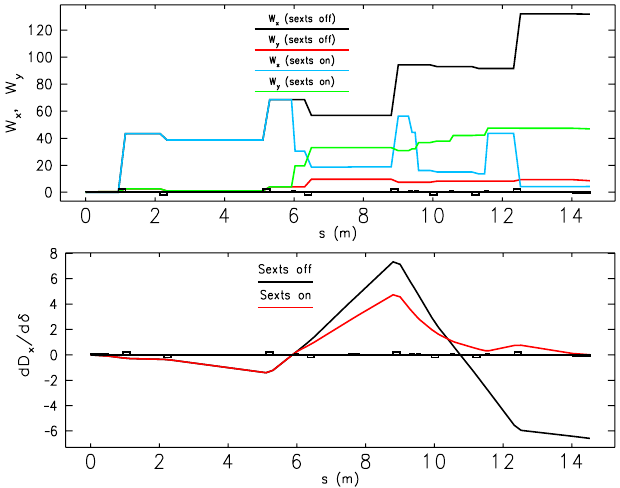
FIG. 3. Top: Chromatic amplitude functions in the injection achromat before (black, red) and after (blue, green) correction. Bottom: Chromatic derivative of dispersion before (black) and after (red)